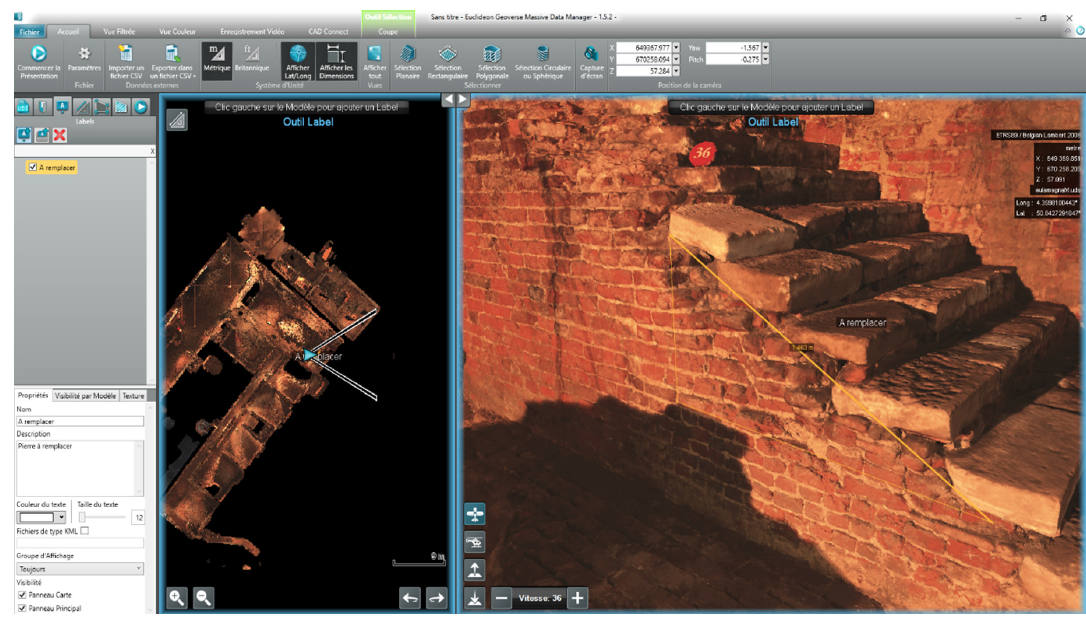
Figure 21. The usage of both the measurement and labelling tools on a section of the point cloud within the point cloud Interface.